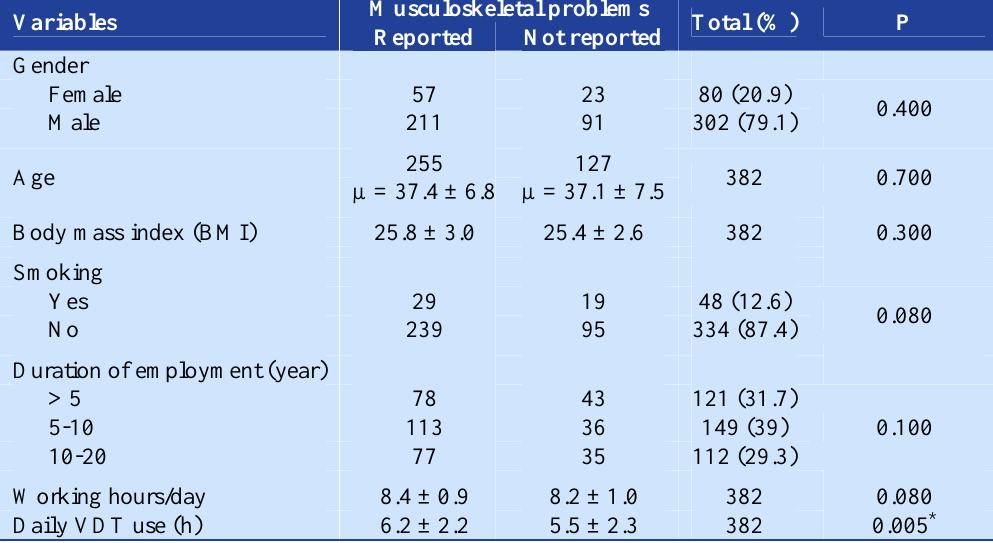
Table 1. Association between some demographic characteristics and musculoskeletalproblems among Sanandaj bank tellers (n = 382)